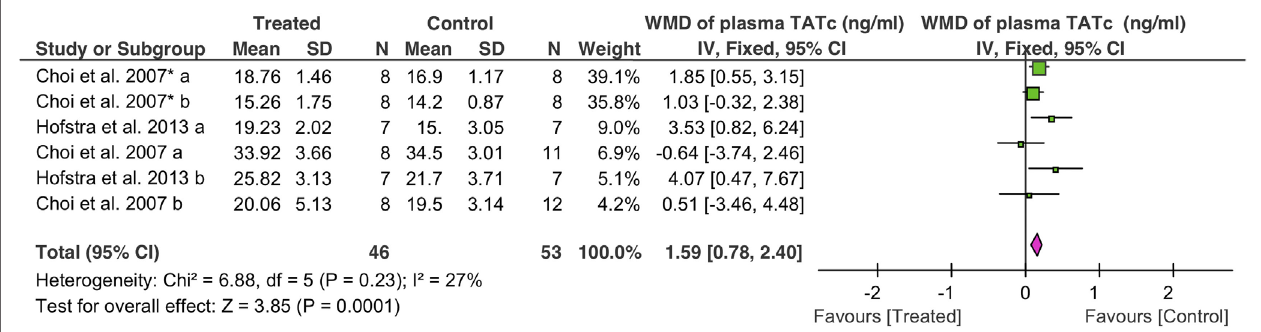
FiGURe 5 | Effect of fibrinolytic therapy on plasma thrombin–antithrombin complexes.